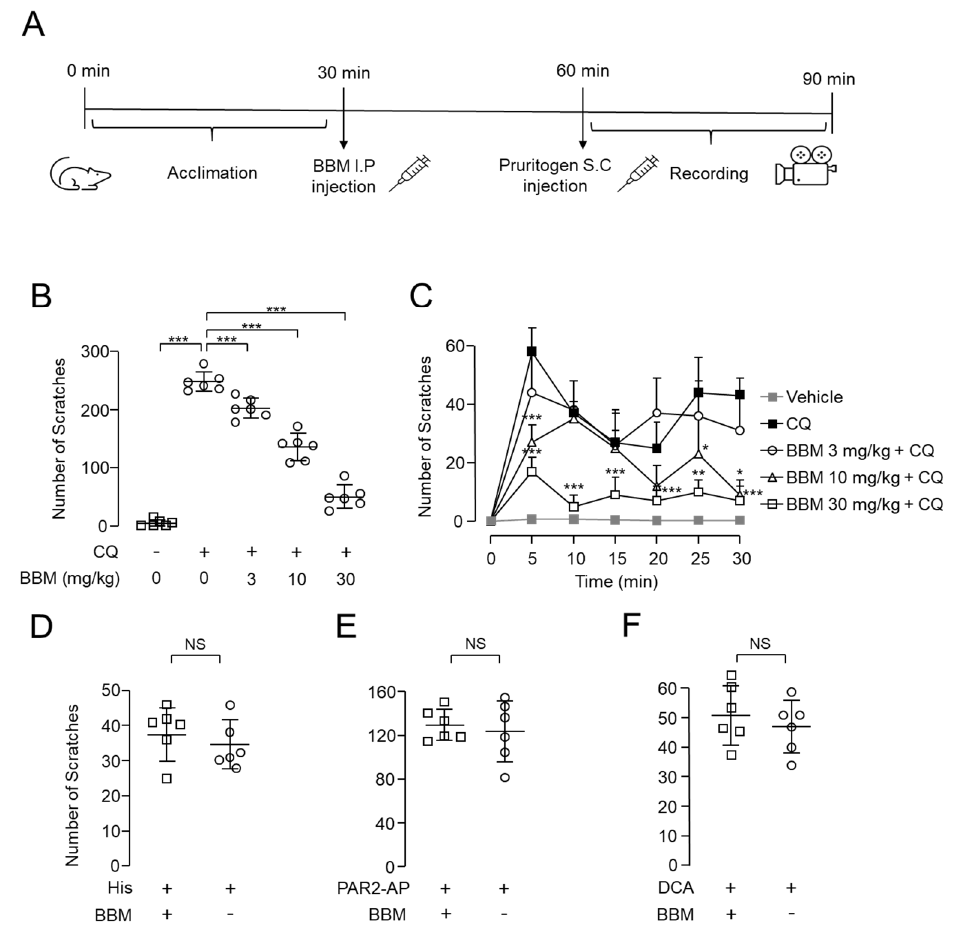
Figure 7. Effect of berbamine on acute pruritogen-induced pruritus in mice: ( A ) Scheme of acute pruritogen-induced pruritus mouse model. ( B ) Effect of BBM on scratching bouts during 30 min after subcutaneous injection of CQ (400 µ g/50 µ L). ( C ) Time-course graphs of scratching bouts at 5 min intervals (mean ± S.D., n = 6). Statistical significance of differences between each group and CQ group was assessed using one-way ANOVA with Tukey’s post hoc test. * p < 0.05, ** p < 0.01, *** p < 0.001. ( D – F ) Effect of BBM on the scratching bouts during 30 min after subcutaneous injection of histamine (10 µ M), PAR2-AP (100 µ g/50 µ L), and DCA (50 µ g/50 µ L). Results were summarized as mean ± S.D. ( n = 6). Statistical significance of differences was determined using Student’s t -test. NS, not significant ( p >